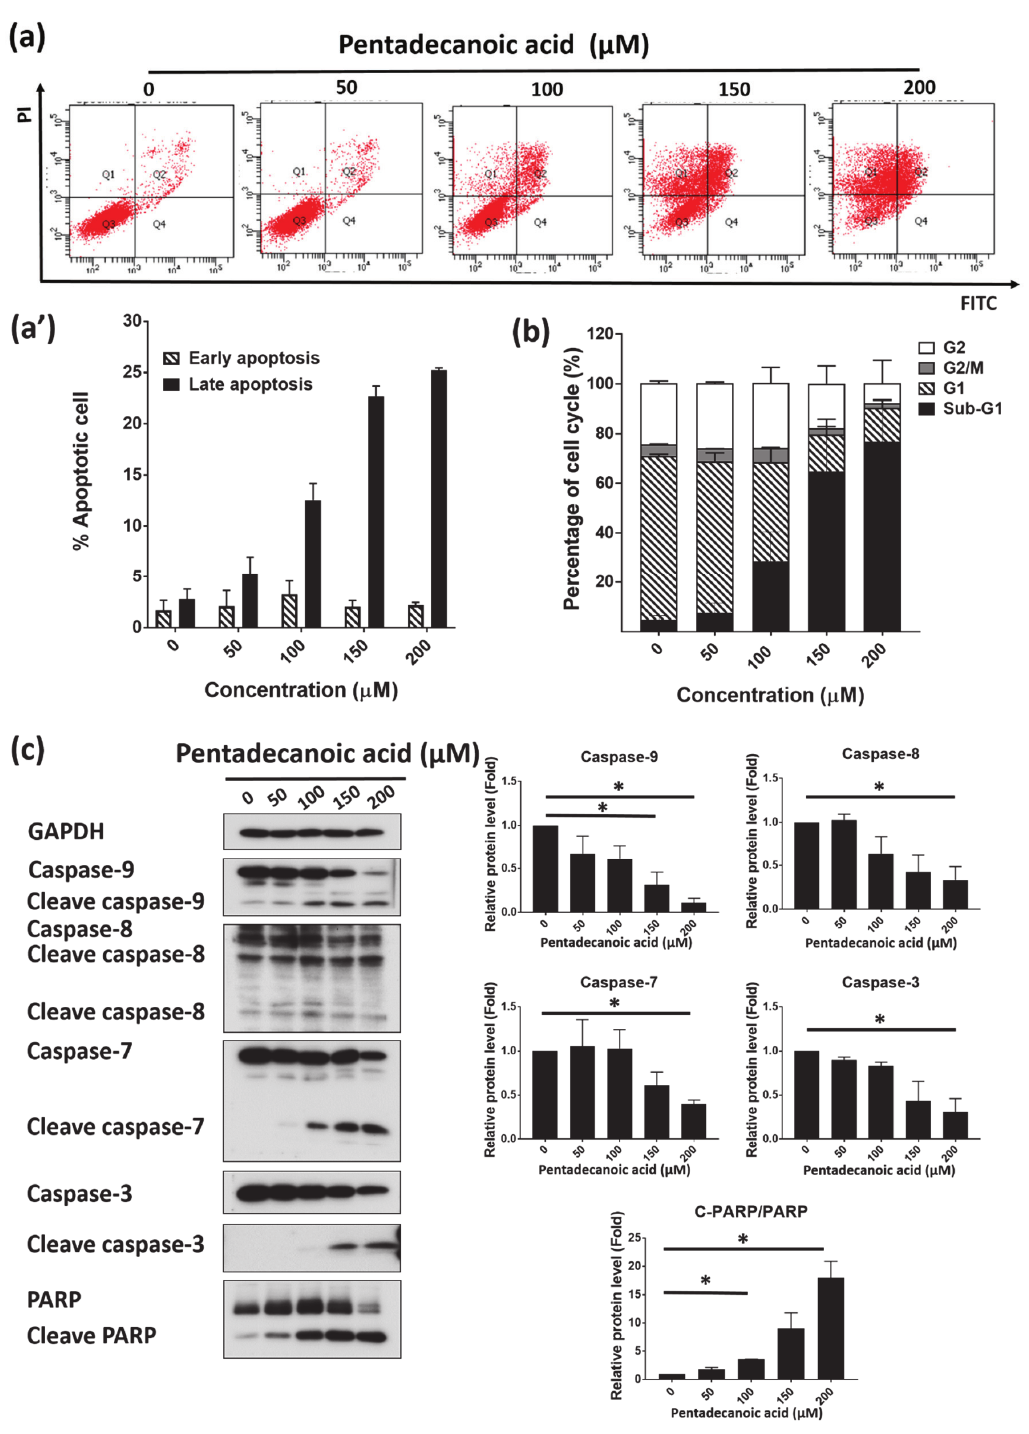
Figure 6. Pentadecanoic acid induced apoptosis in MCF-7/SC. ( a , a’ ) Fluorescein-conjugated annexin V (annexin V-FITC) vs. propidium iodide (PI) staining analysis showing apoptosis induction following treatment with pentadecanoic acid for 48 h. ( b ) Cell cycle analysis of MCF-7/SC exposed to pentadecanoic acid for 48 h. ( c ) The levels of apoptosis markers were assessed by Western blot experiments following pentadecanoic acid treatment for 48 h. GAPDH was used as a loading control. Data are shown as the mean ± standard deviation of three biologically independent experiments. * p < 0.05 vs. control.